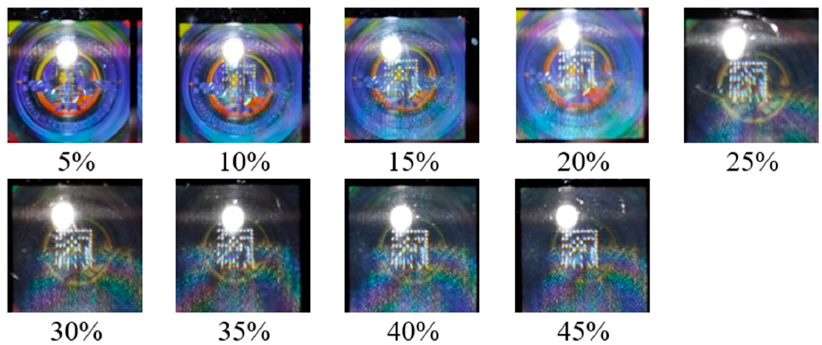
Figure 7. Hidden coded optical mark (exposure fitting).